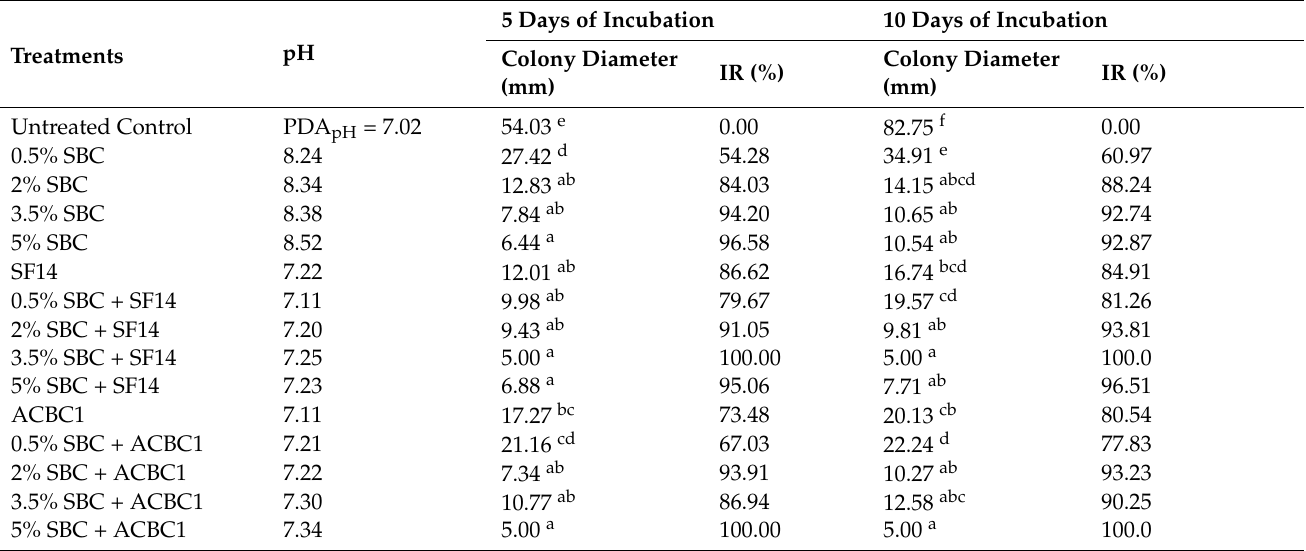
Figure 2. Effect of different concentrations of SBC solution (%), and duration (h) on the bacterial cell growth of SF14 ( Bacillus amyloliquefaciens ) grown on PDB medium for 48 h at 25 ◦ C under agitation. Treatments having the same letters (a–g) are not significantly different according to the LSD ( p < 0.05). Table 1. Inhibition rate of mycelial growth (%) of M. fructigena obtained by SBC concentrations, antag- onistic bacteria ( Bacillus amylolquefaciens SF14 and Alcaligenes faecalis ACBC1), and their combinations after 5 and 10 days of incubation at 25 ◦ C in